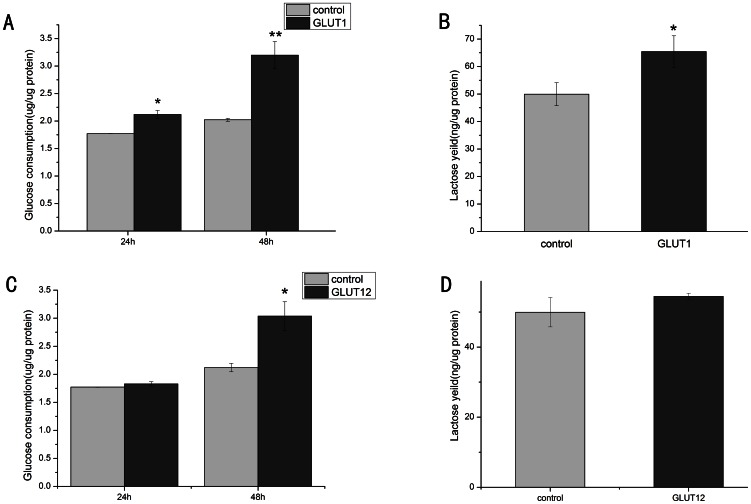
Glucose uptake (A and C) and lactose secretion (B and D) in GT1-GMGE and GT12-GMGE respectively.Glucose uptake was detected in 24 h and 48 h in GT1-GMGE and GT12-GMGE, while lactose secretion was detected in 48 h. Vertical coordinate means glucose uptake or lactose concentration and total protein radio. Horizontal coordinate means different groups. Data are expressed as means ± SE (n = 3). *P<0.01, compared with GMGE.